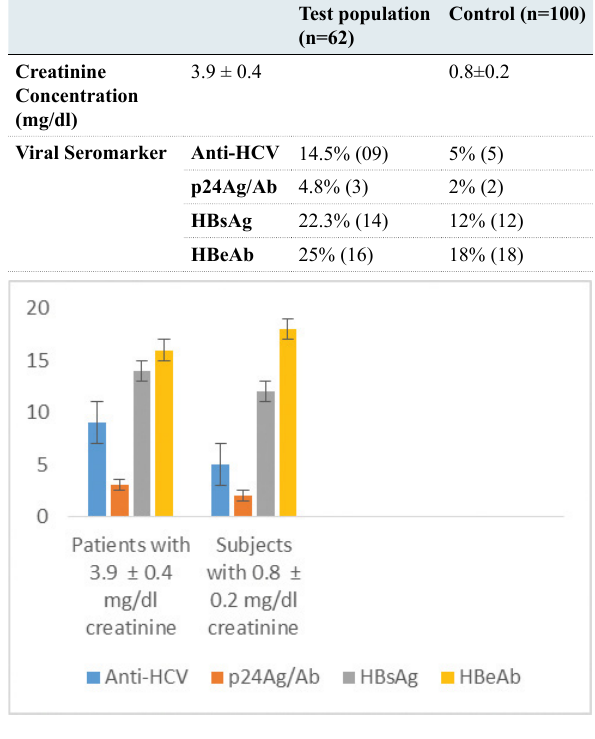
Figure 1: Viral seromarkers in relationship with plasma creatinine in the